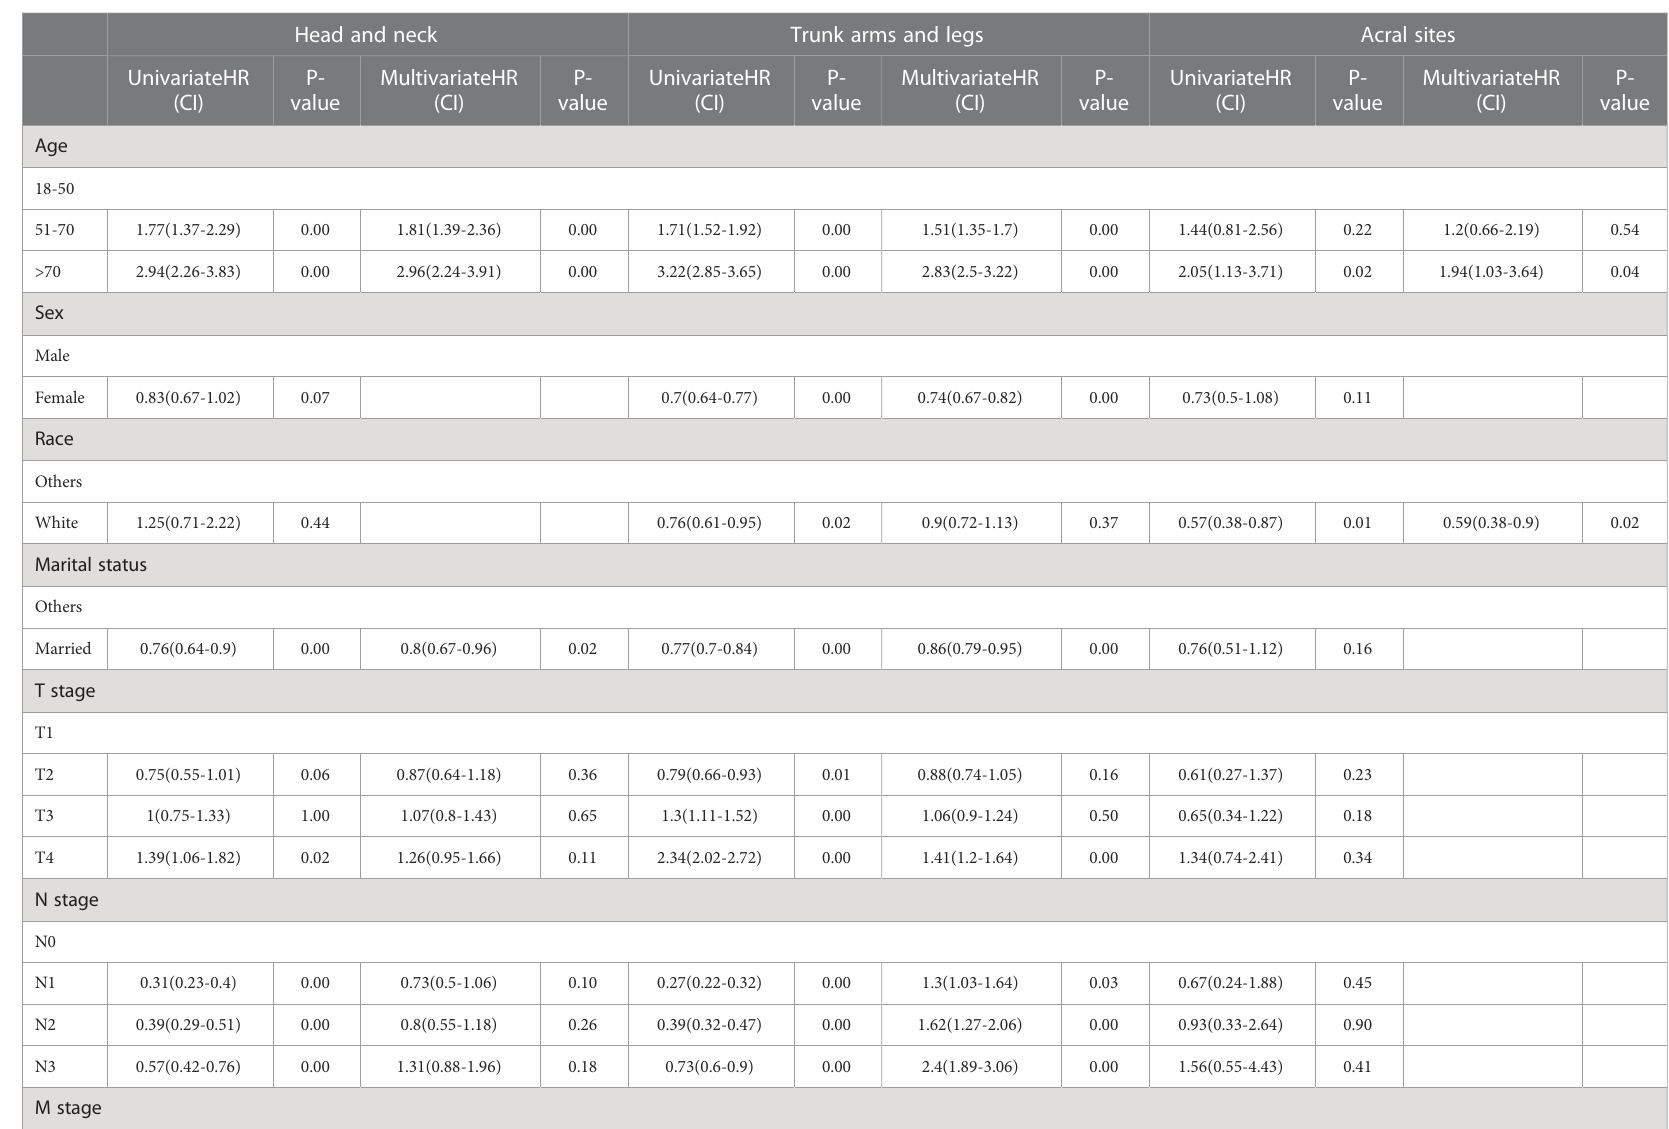
TABLE 5 Univariate and multivariate cox analysis of training